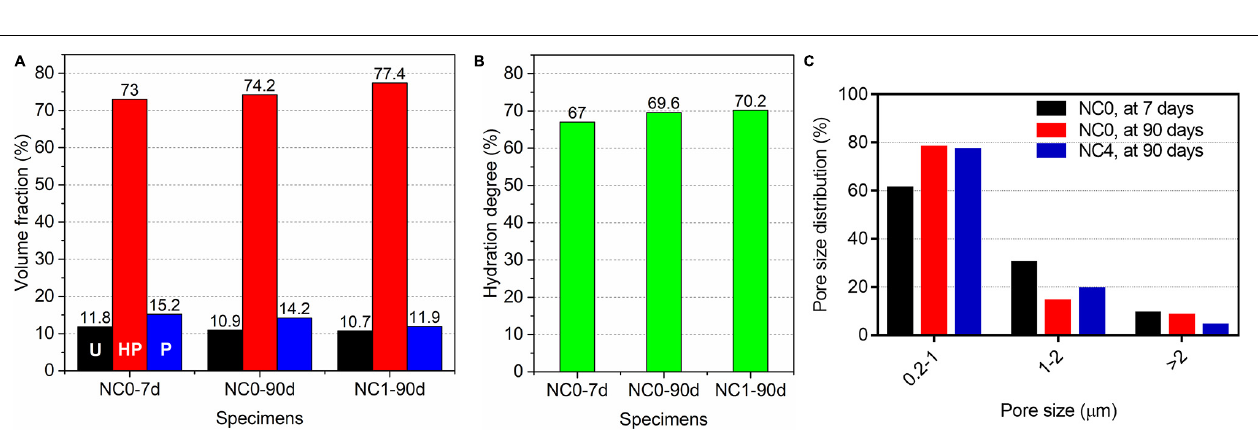
FIGURE 14 | (A) Measured volume fractions of constituent phases in specimens. U, anhydrous; HP, hydration products; P, pores. (B) Degree of cement hydration. (C) The pore size distribution of 3DPC with and without NC.